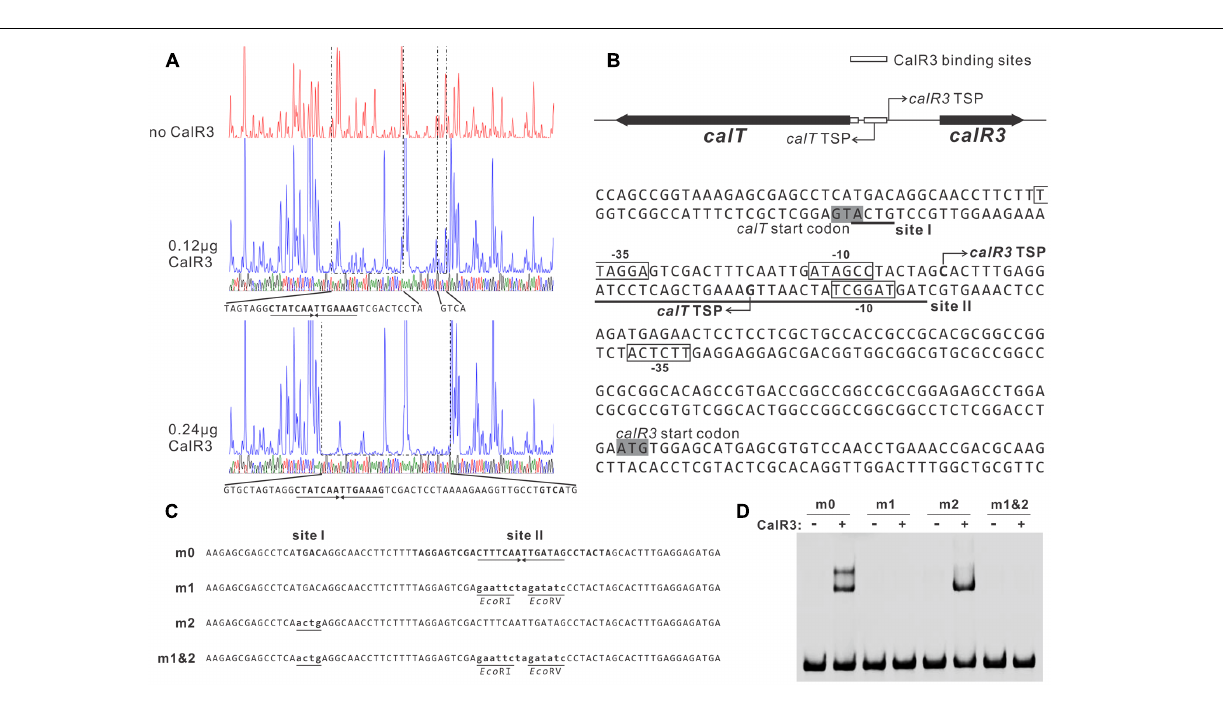
Frontiers in Microbiology |